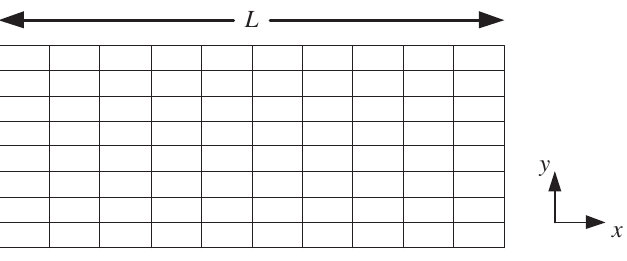
Figure A1. A simplified schematic of the basic mesh at t = 0.